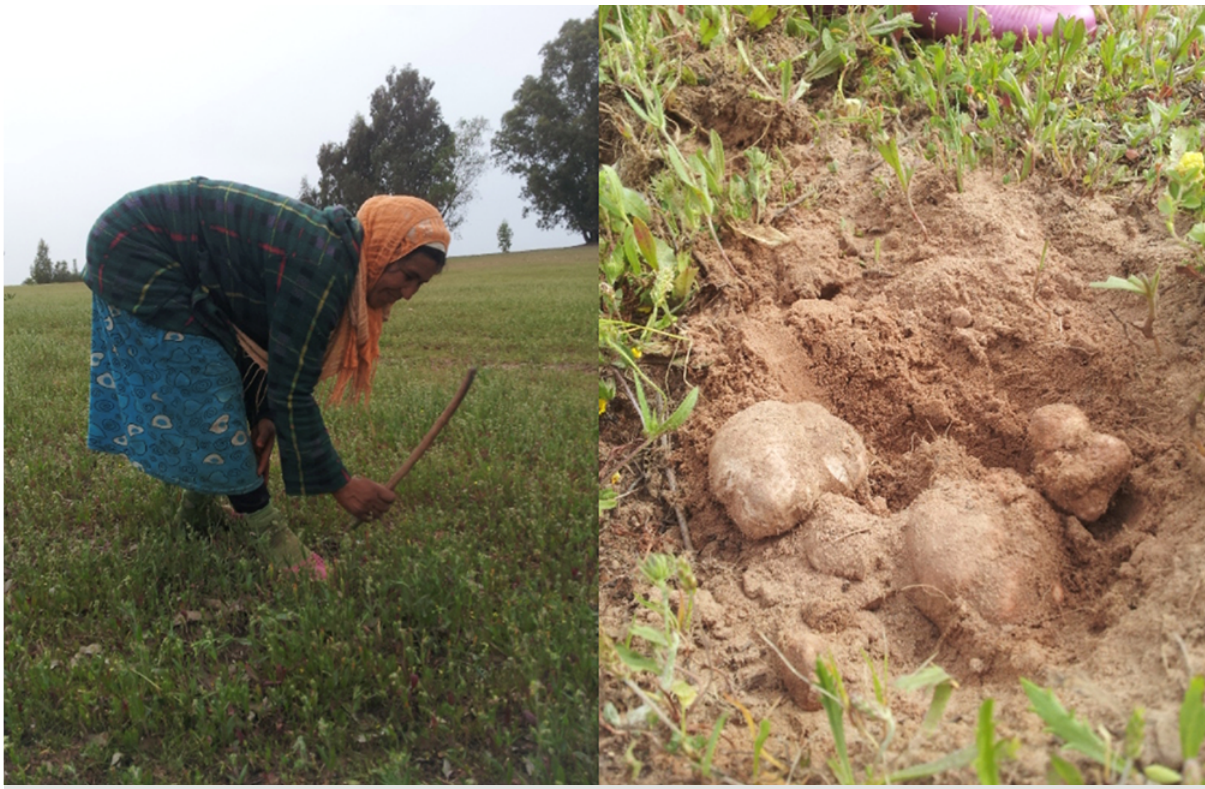
Fig. 2 Desert truffles ( Terfezia arenaria ) being located in Morocco using the “stick” method (left) and freshly unearthed fruiting bodies (right). The photographs were taken by the corresponding author.